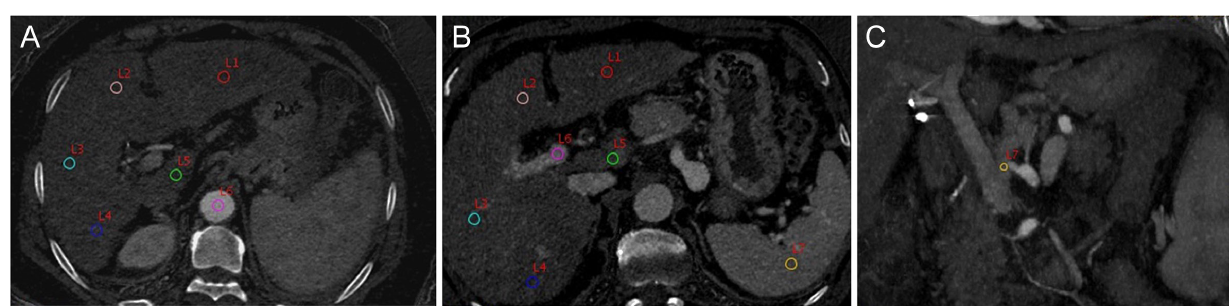
Figure 1. Spectral CT images (A) Axial ROI in hepatic artery phase (L1, L2, L3, L4, L5, and L6 represent iodine density (mg/mL) in the left lateral lobe, left medial lobe, right anterior lobe, right posterior lobe, caudate lobe, and abdominal aorta, respectively, in the hepatic artery phase). (B) Axial ROI in hepatic portal phase (L1, L2, L3, L4, L5, L6, and L7 represent iodine density in the left lateral lobe, left medial lobe, right anterior lobe, right posterior lobe, caudate lobe, main portal vein, and spleen parenchyma, respectively, in the hepatic portal phase). (C) Coronal ROI of the left gastric vein (L7 represent iodine density in the left gastric